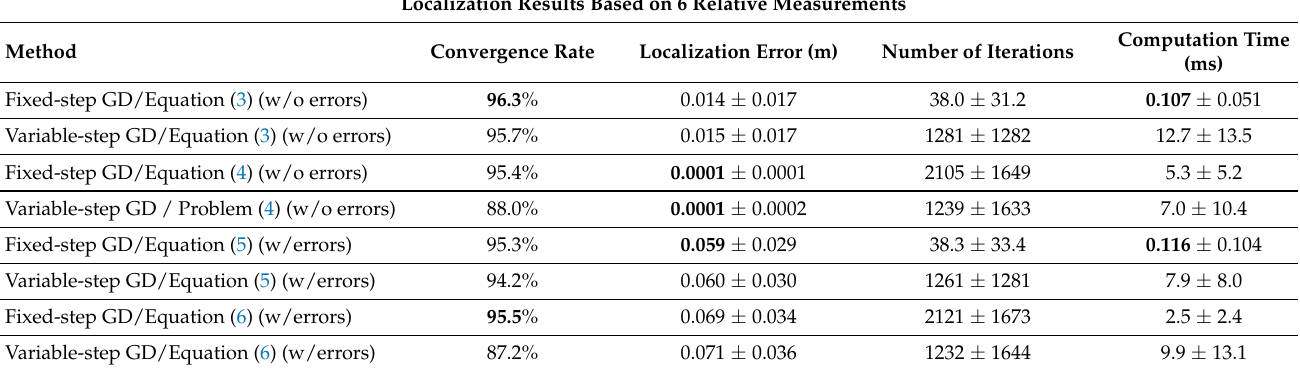
Table 4. Comparative localization results using the different formulations of the estimation problem based on 6 relative measurements, with and without taking into account uncertainty models.